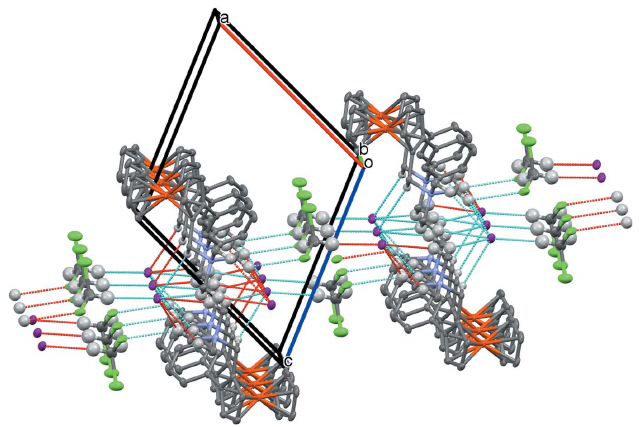
Figure 4 Partial packing view showing the C—H (cid:2)(cid:2)(cid:2) X ( X = I, Cl) intermolecular interactions resulting in the formation of ribbons parallel to the b axis and C—H (cid:2)(cid:2)(cid:2) Cl interactions linking the ribbons to form a layer parallel to (101) plane. The dichloromethane solvate builds the link between the layers.